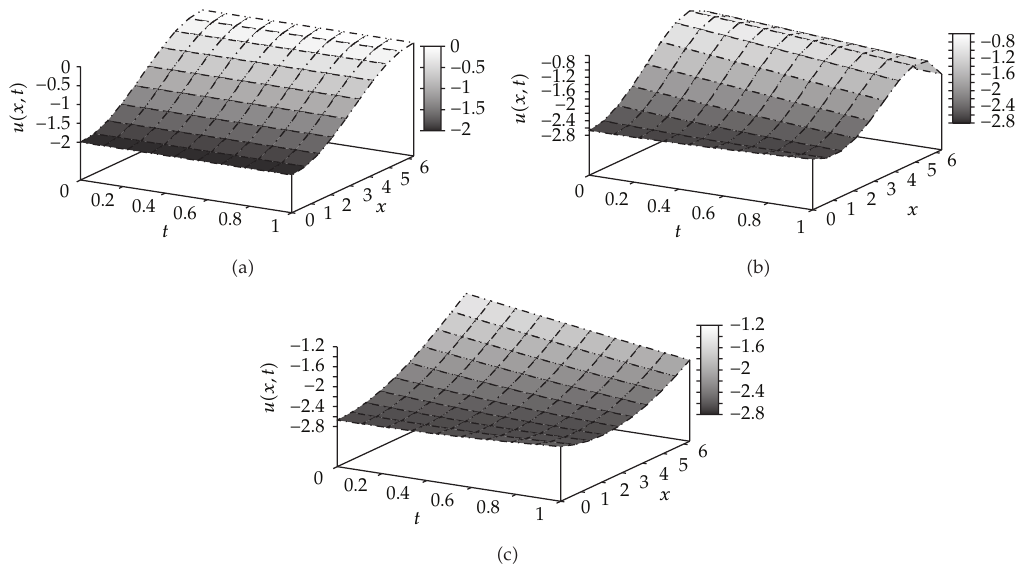
Figure 2: The approximate solution of fractional Rosenau-Hynam equation when α (cid:8) 1 . 0 and c (cid:8) 1 . 0